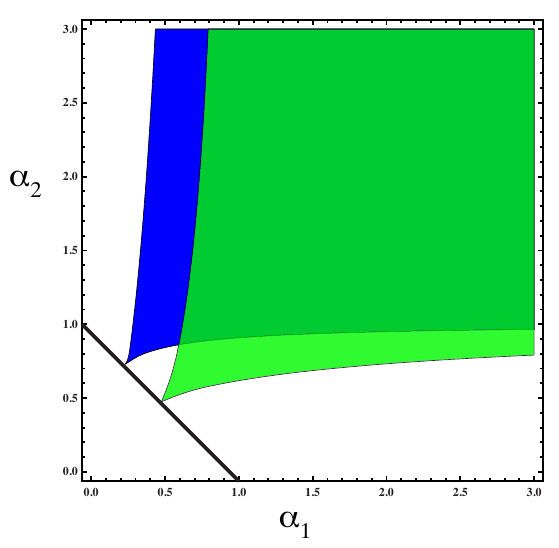
Figure 2 . The shaded regions are the allowed values of (cid:11) 1 ; (cid:11) 2 for the illustrative choices ~r = p p p p (1 = 2 ; 1 = 2) (green) and ~r = (1 = 10 ; 3 = 10) (blue). There are kinks located at ( (cid:11) 1 ; (cid:11) 2 ) = (1 = 2 ; 1 = 2) and ( (cid:11) 1 ; (cid:11) 2 ) = (1 = 4 ; 3 = 4) for the two choices of unit vectors. The black line is (cid:11) 1 + (cid:11) 2 =